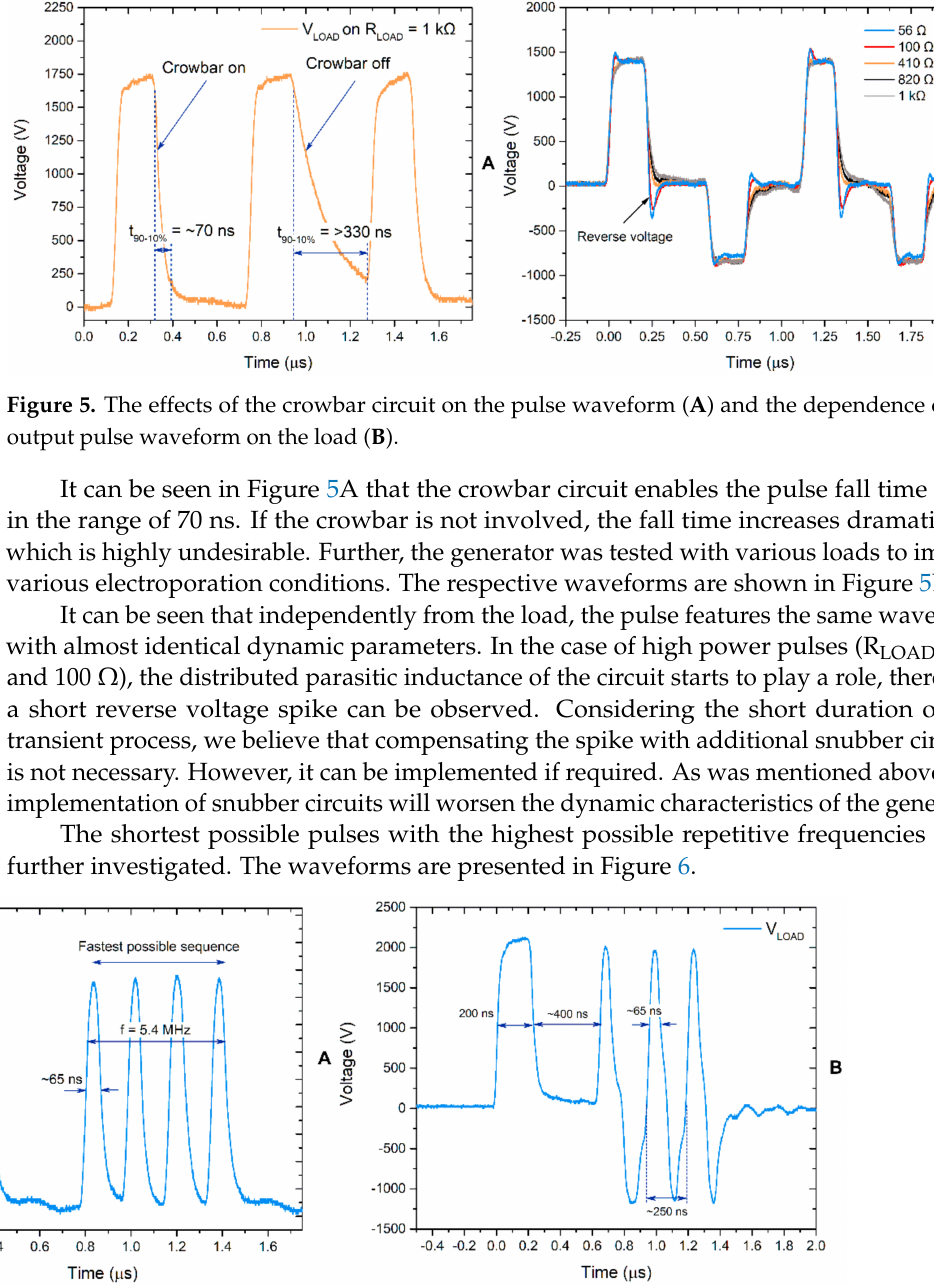
Figure 6. Exemplary high frequency unipolar ( A ) and bipolar ( B ) sequences featuring shortest possible pulses, R LOAD = 1 k Ω